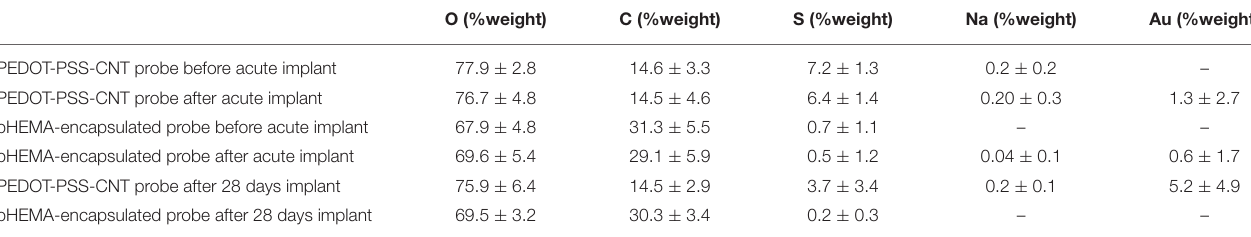
TABLE 2 | Relative percentage of chemical elements found by EDS on: PEDOT-PSS-CNT non-encapsulated microspheres before and after acute implantation (mean values for 4 probes, 4 spectra for each probe, 3 insertions); pHEMA-encapsulated microspheres before and after acute implant (mean values for 4 probes, 4 spectra for each probe, 3 insertions); a PEDOT-PSS-CNT non-encapsulated microsphere and a pHEMA-encapsulated one (mean values of 4 spectra each) 28 days after